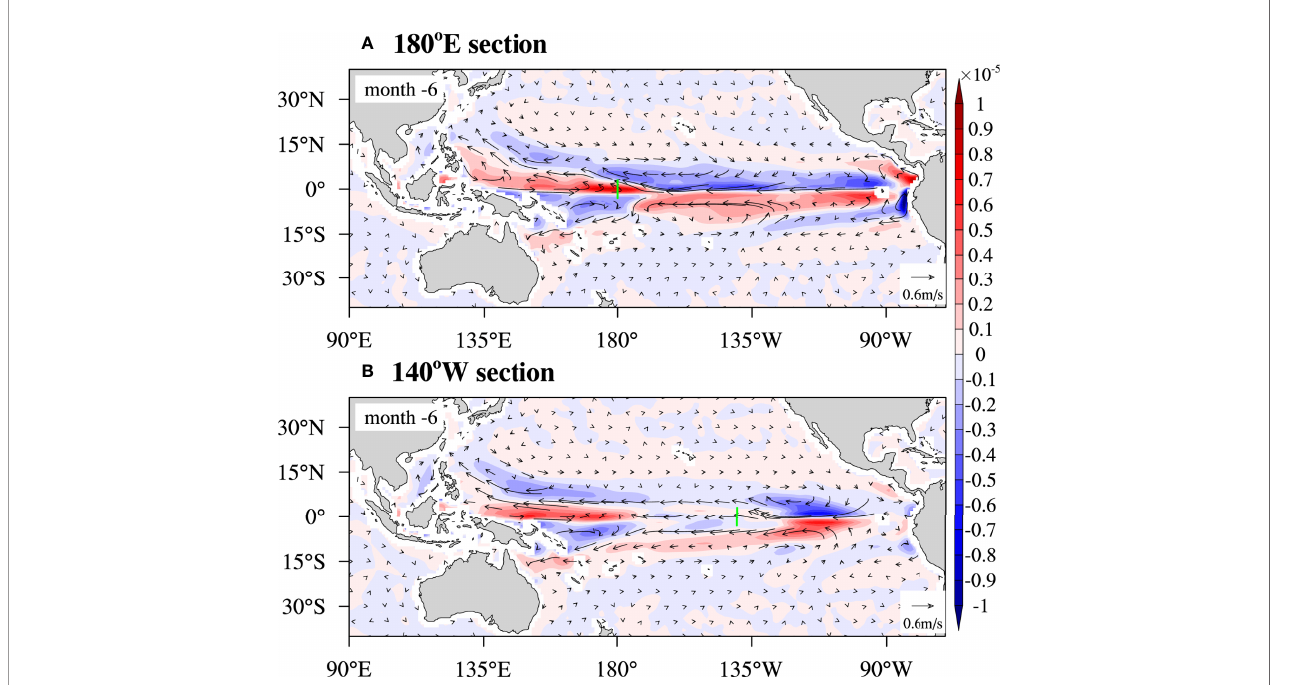
FIGURE 13 | Horizontal distributions of the sensitivity-like wind velocity perturbations (vectors; m s -1 ) and corresponding wind curl (color shading; s -1 ) at month – 6. (A) and (B) represent the target sections at 180°E and 140°W,